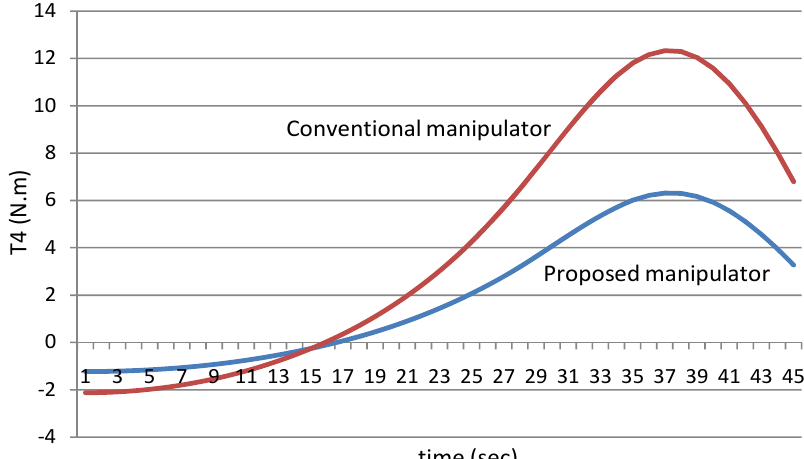
Figure 13. The values of the torques of the fourth joint using the both manipulators.